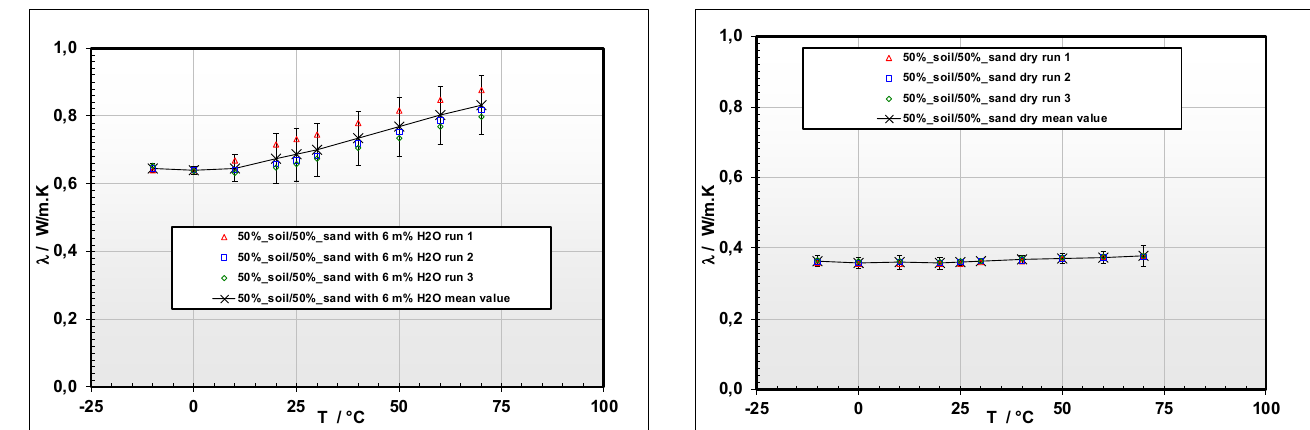
Figure 11. Effective thermal conductivity of a 50/50 soil/sand mixture with 6% water and as a dry mixture.